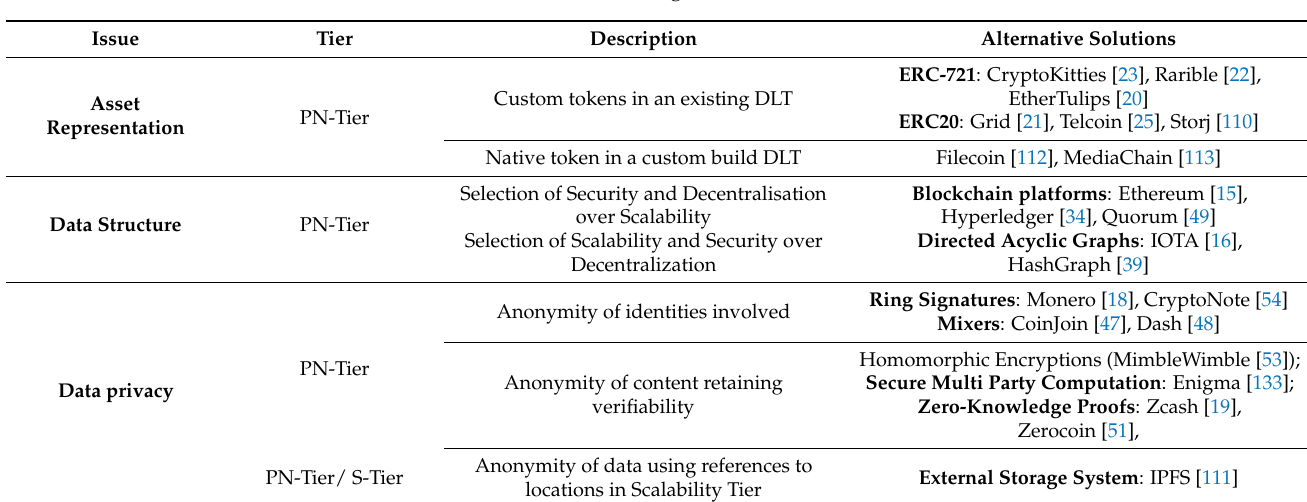
Table 10. DLT technologies and